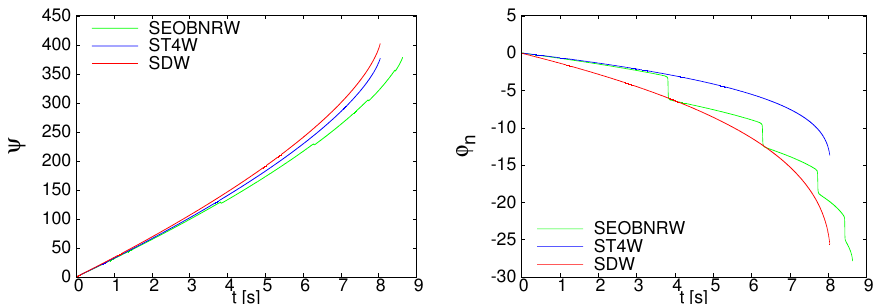
Figure 8. The evolutions of ψ and φ n are plotted for SEOBNRv3 (green), SpinTaylorT4 (blue) and SpinDominatedWf